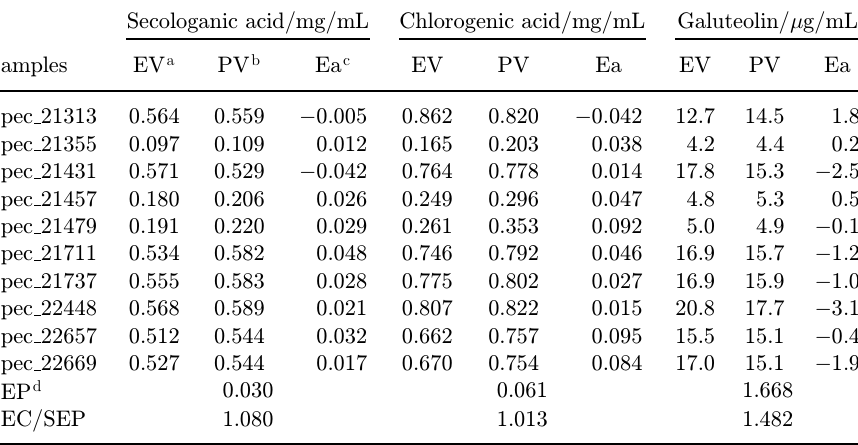
Table 6. Experimental vs. predictive values of the three active compounds.